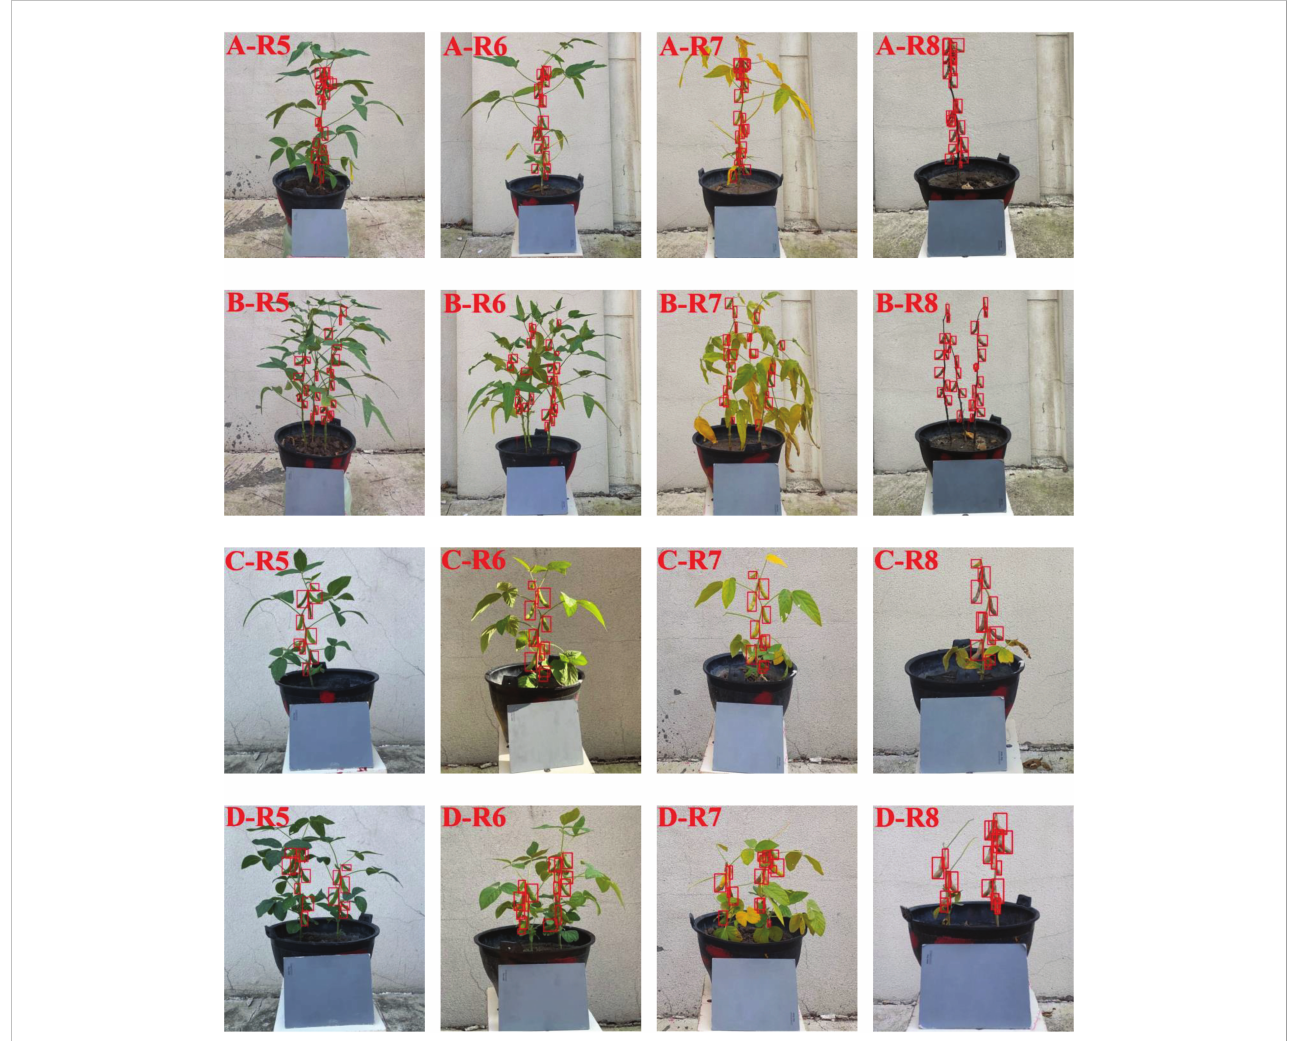
FIGURE 3 Soybean pod ’ s marking images of two varieties in different growth stages (A) Single soybean plant of Suinong 26; (B) Multi soybean plants of Suinong 26; (C) Single soybean plant of Heihe 49; (D) Multi soybean plants of Heihe